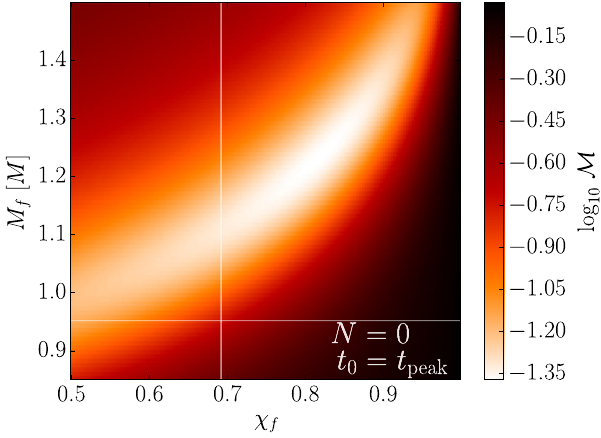
FIG. 5. The mismatches for the l ¼ m ¼ 2 mode between NR and Eq. (1) over a grid of χ f and M f with N ¼ 0 , the fundamental mode only, and t 0 ¼ t . The white horizontal and vertical lines peak correspond to the remnant values from NR. As the fundamental mode is subdominant at this time, this single-mode model is a poor probe of the underlying remnant mass and spin. Note that the mass and mismatch scales used in this figure are significantly different from Fig. 4 because of the discrepant single-mode fit at early times.